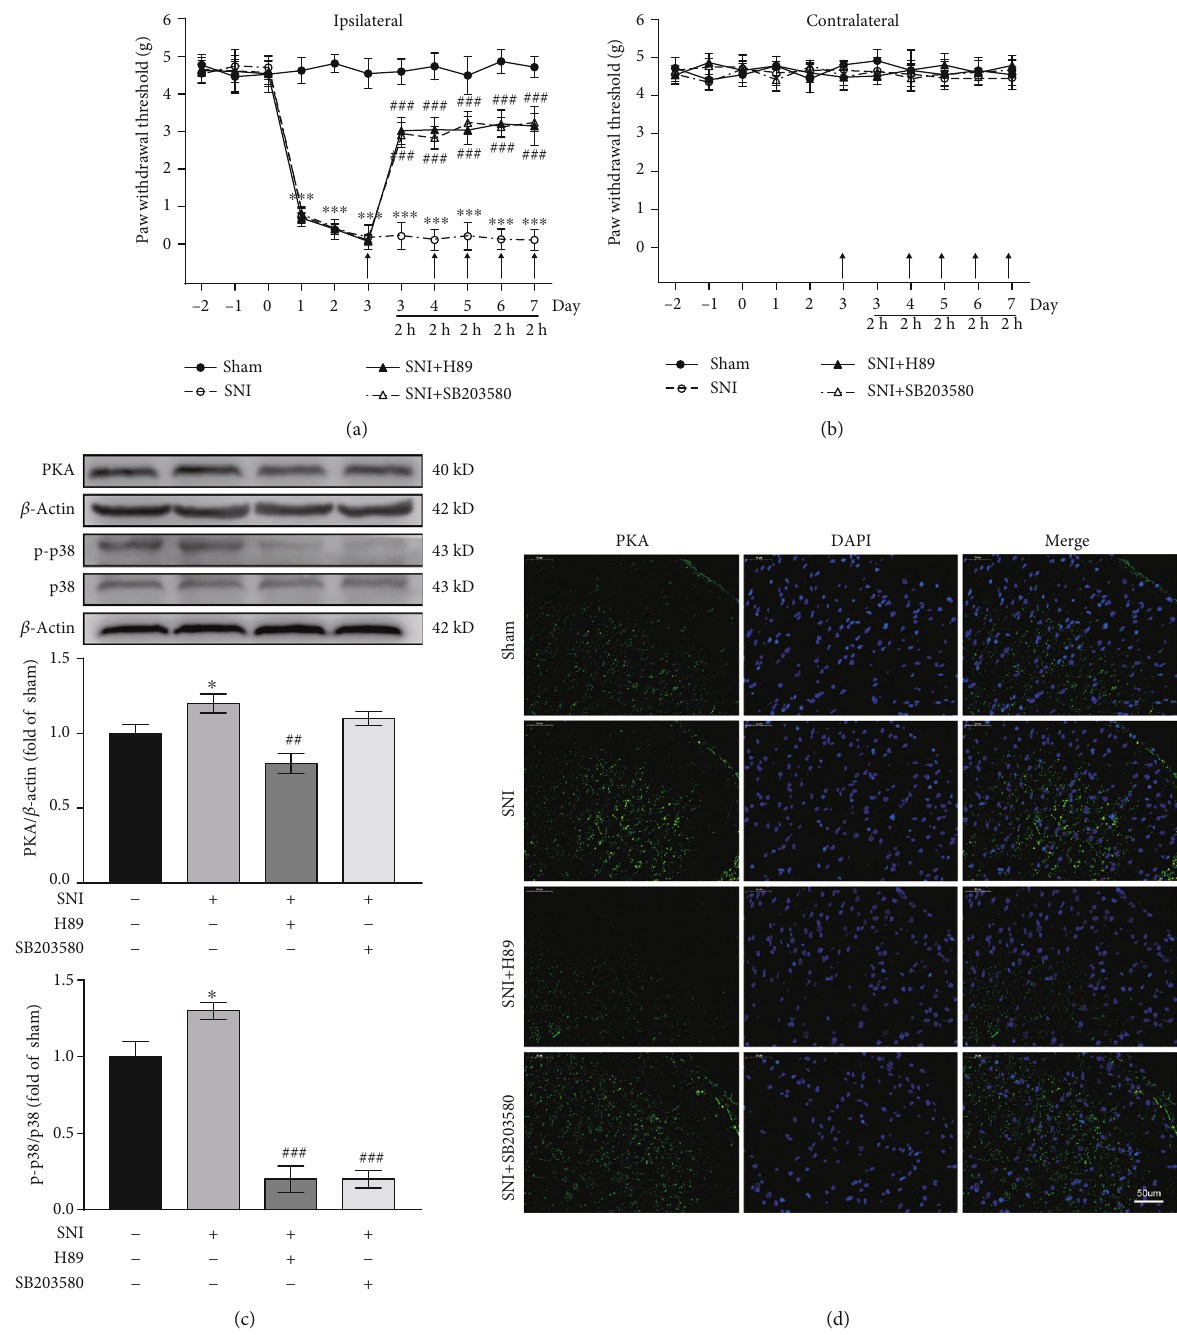
Figure 7: Intrathecal injection of PKA and p38MAPK inhibitors alleviates mechanical hyperalgesia. (a, b) Ipsilateral PWT (a) and contralateral PWT (b) after intrathecal injection of PKA and p38MAPK inhibitors ( n = 9 ). Arrows indicate the time points at which inhibitors were administered. PWT was measured 2h after inhibitor injection. ∗∗∗ P < 0 : 001 versus Sham group, ### P < 0 : 001 versus SNI group. (c) Western blots and quanti fi cation of spinal cord PKA and p-p38 expression ( n = 3 ). ∗ P < 0 : 05 versus Sham group, ## P < 0 : 01 , ### P < 0 : 001 versus SNI group. (d) Immuno fl uorescence images showing PKA expression in the dorsal horn of the spinal cord. PKA is